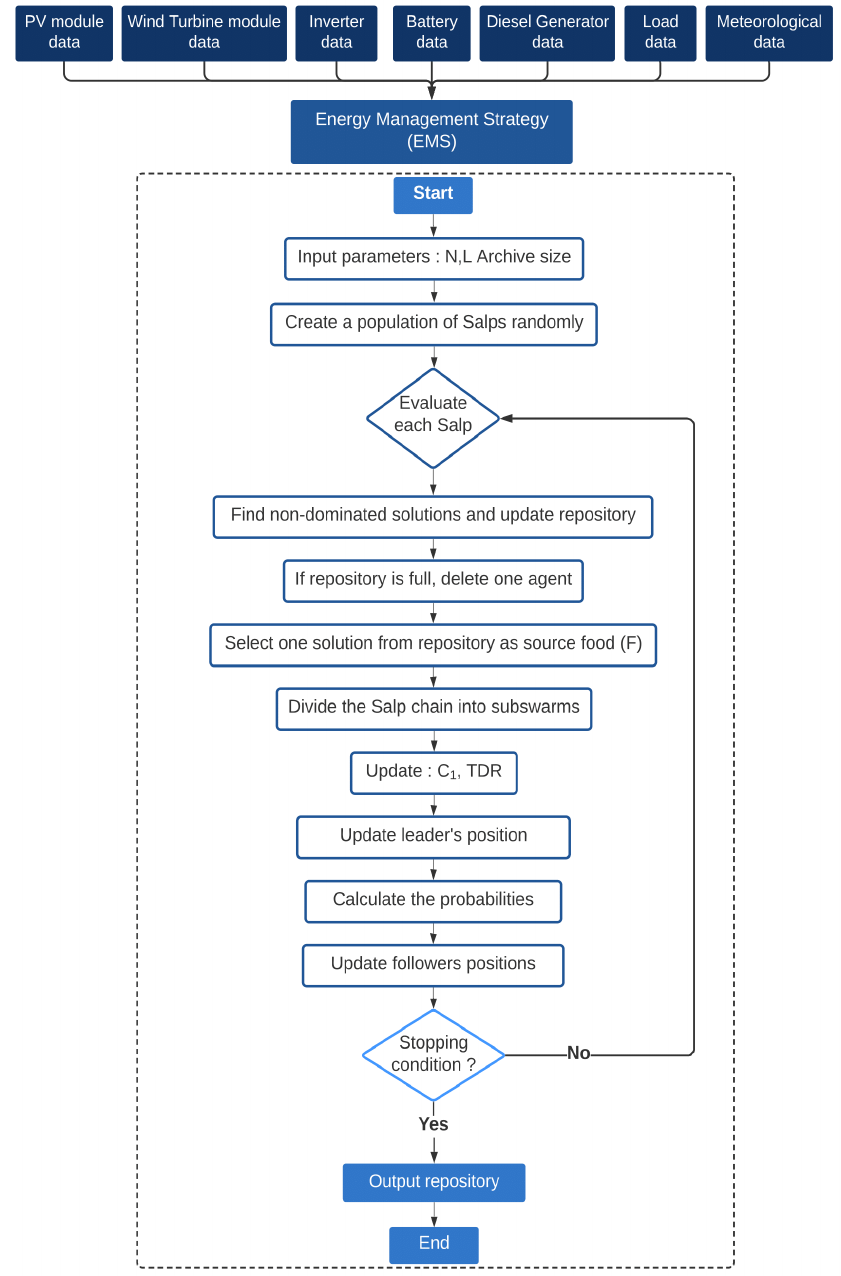
Figure 11. Flowchart of the proposed approach.